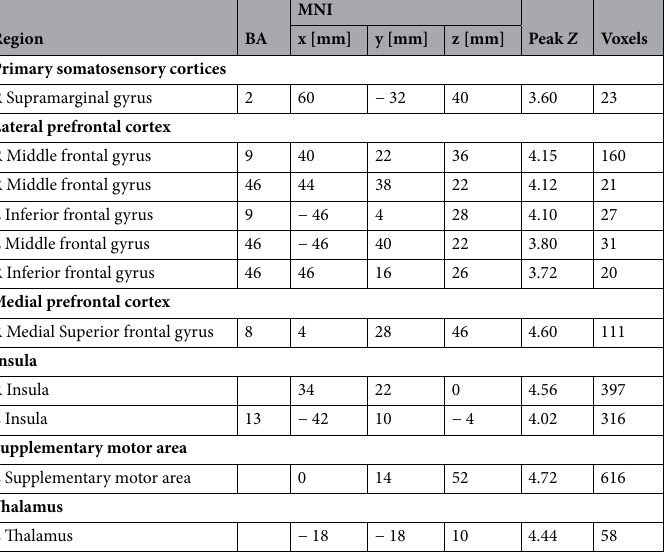
Table 6. MNI coordinates of the activated clusters in trial 6. In this trial, a stimulation current amplitude that was 1.0 times that of the standard amplitude was applied. Threshold values of uncorrected p and cluster extent k were set as smaller than 0.001 and more than 20, respectively. L left hemisphere; R right hemisphere.